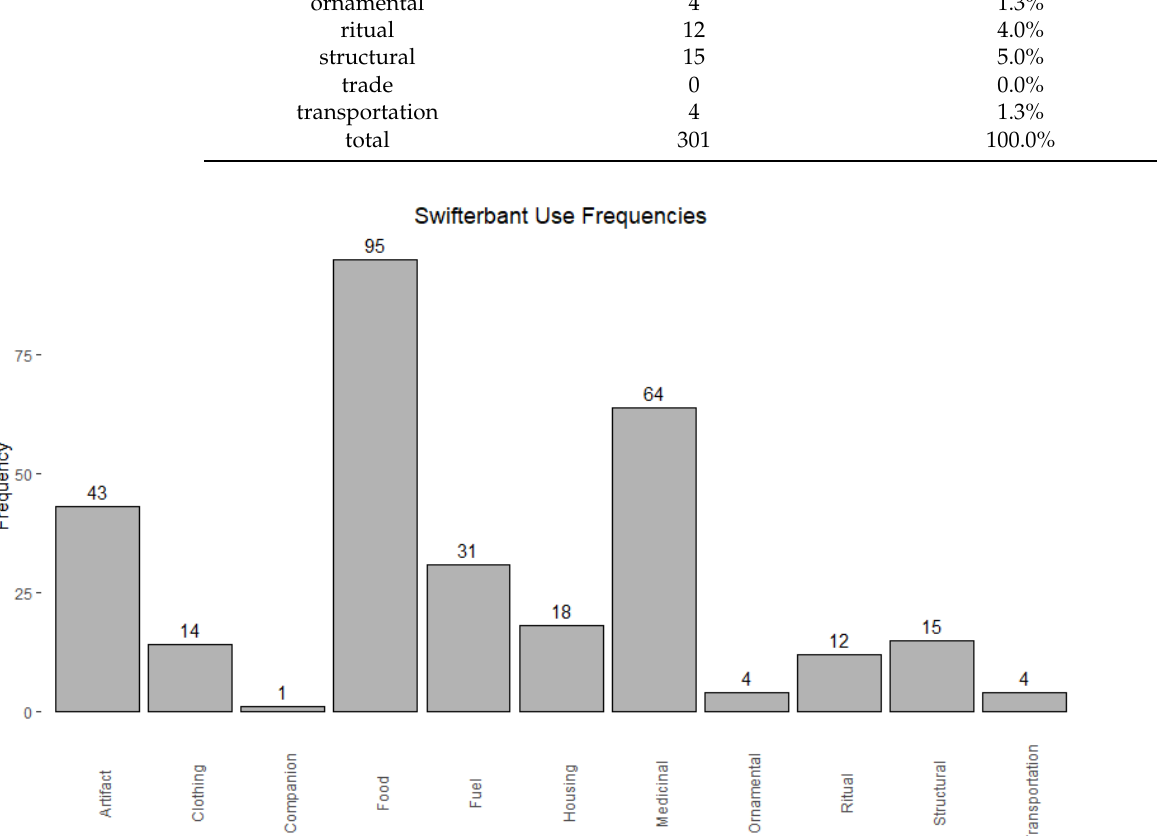
Figure 2. Frequency of representation for each use type.